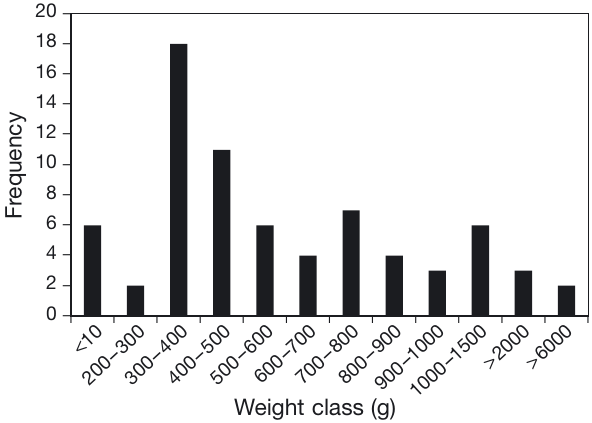
Fig. 5. Size distribution of escaped fish identified by STRUCTURE analysis (n = 72)